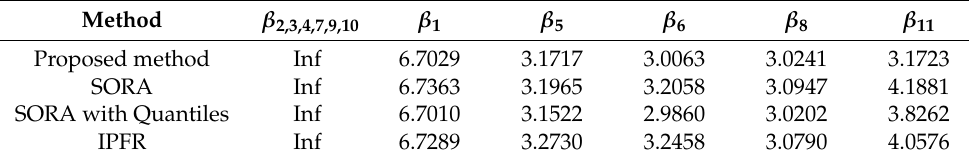
Table 8. Probabilistic constraints comparison of the Hock and Schittkowski problem.